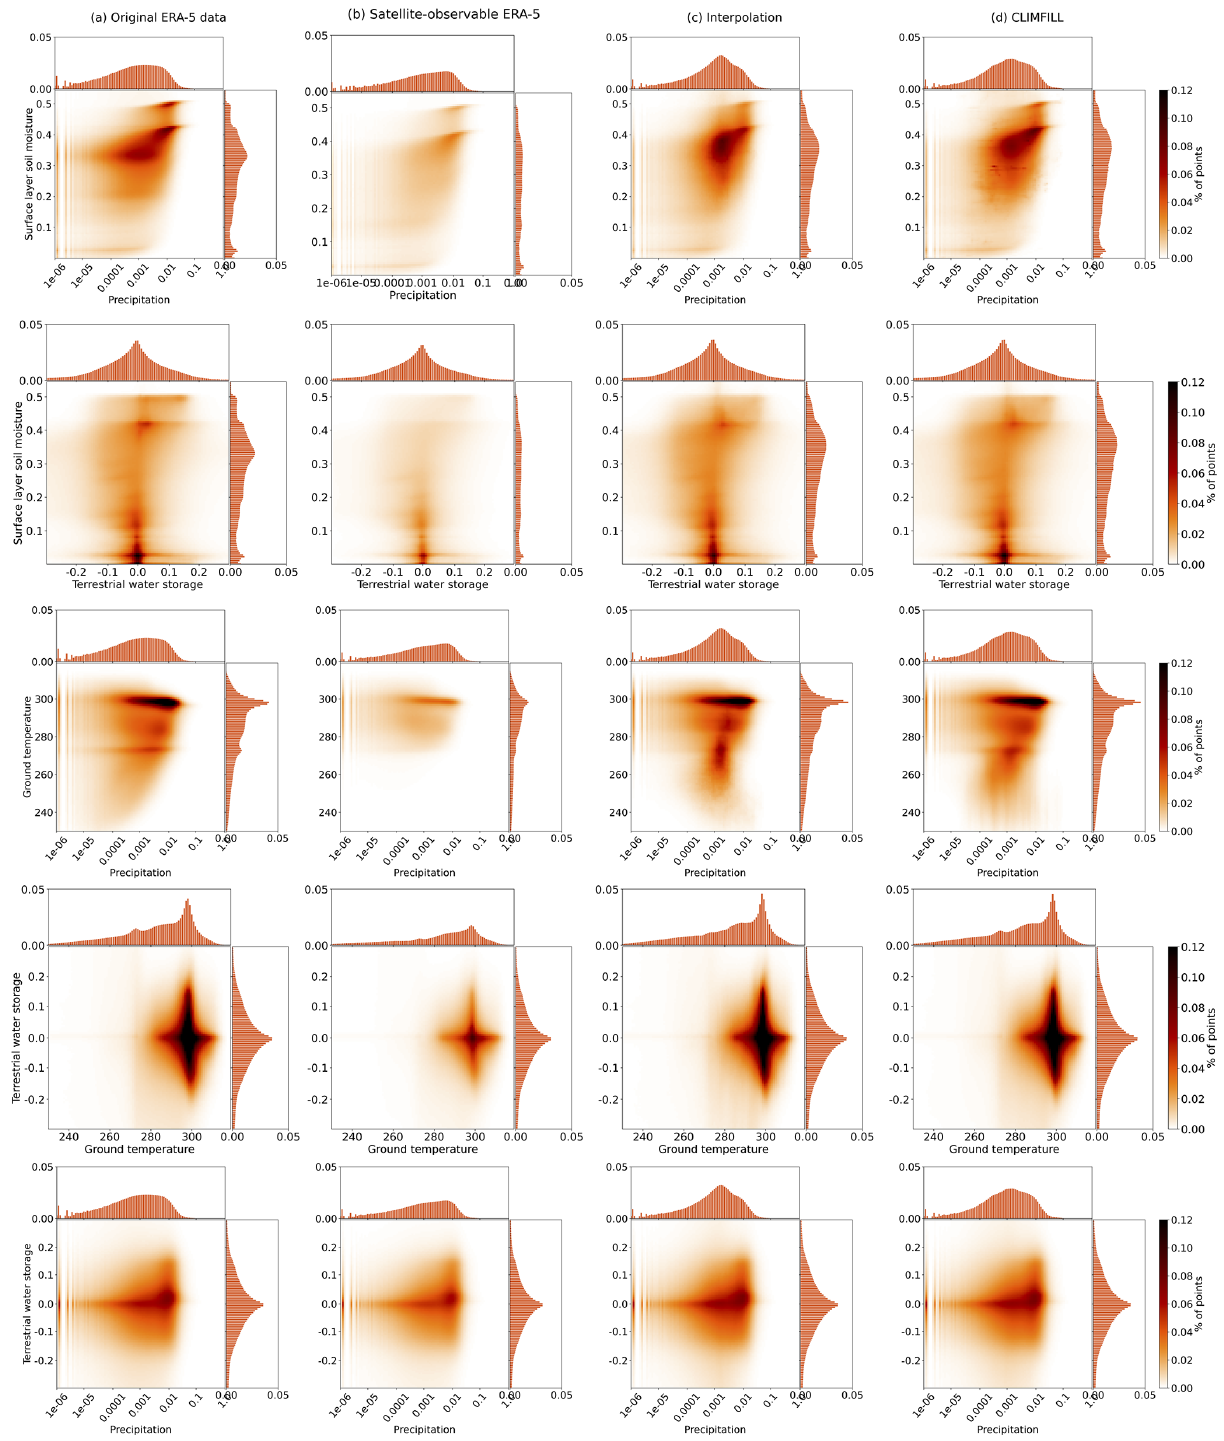
Figure A1. Improvement of multivariate distribution with CLIMFILL gap filling: 2D histogram for all other combinations of variables (apart from the one already shown in Fig. 7) for the original ERA-5 data, satellite-observable ERA-5 data, the interpolation gap-filled data and CLIMFILL gap-filled